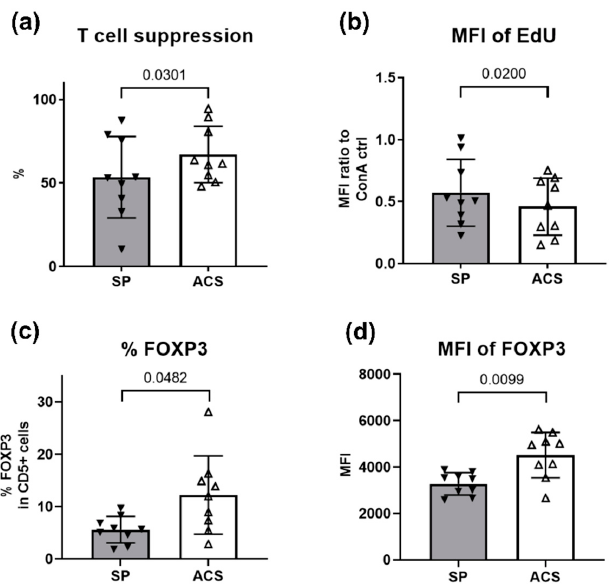
Figure 4. Percentage of T cell proliferation suppression; Bar graphs show the analyses of T cell activity. Error bars depict means with SDs in all panels. ( a ) The percentage of T cell suppression, and ( b ) MFI ratio of EdU in T cells normalized to control are presented. Both ACS and SP groups showed an ability to inhibit T cell proliferation. The ACS group has a greater effect on T cell suppression than SP, and the MFI of EdU-incorporated DNA was lesser in ACS. Evaluation of the FOXP3 population in response to ACS and SP is shown, ( c ) the percentage of FOXP3 + T cells and ( d ) MFI of FOXP3 expression. Filled and blank triangles represent the mean results obtained from 10 OA dogs with technical triplicates. For all Figures, statistical significance was assessed using a two-tailed paired sample t -test, and p values are indicated. Abbreviations, ACS; Autologous conditioned serum, SP; Sham plasma, MFI; Mean fluorescent intensity, EdU; 5-ethynyl-2 (cid:48) -deoxyuridine, ConA; Concanavalin A, CD; Cluster of differentiation, FOXP3; Forkhead box